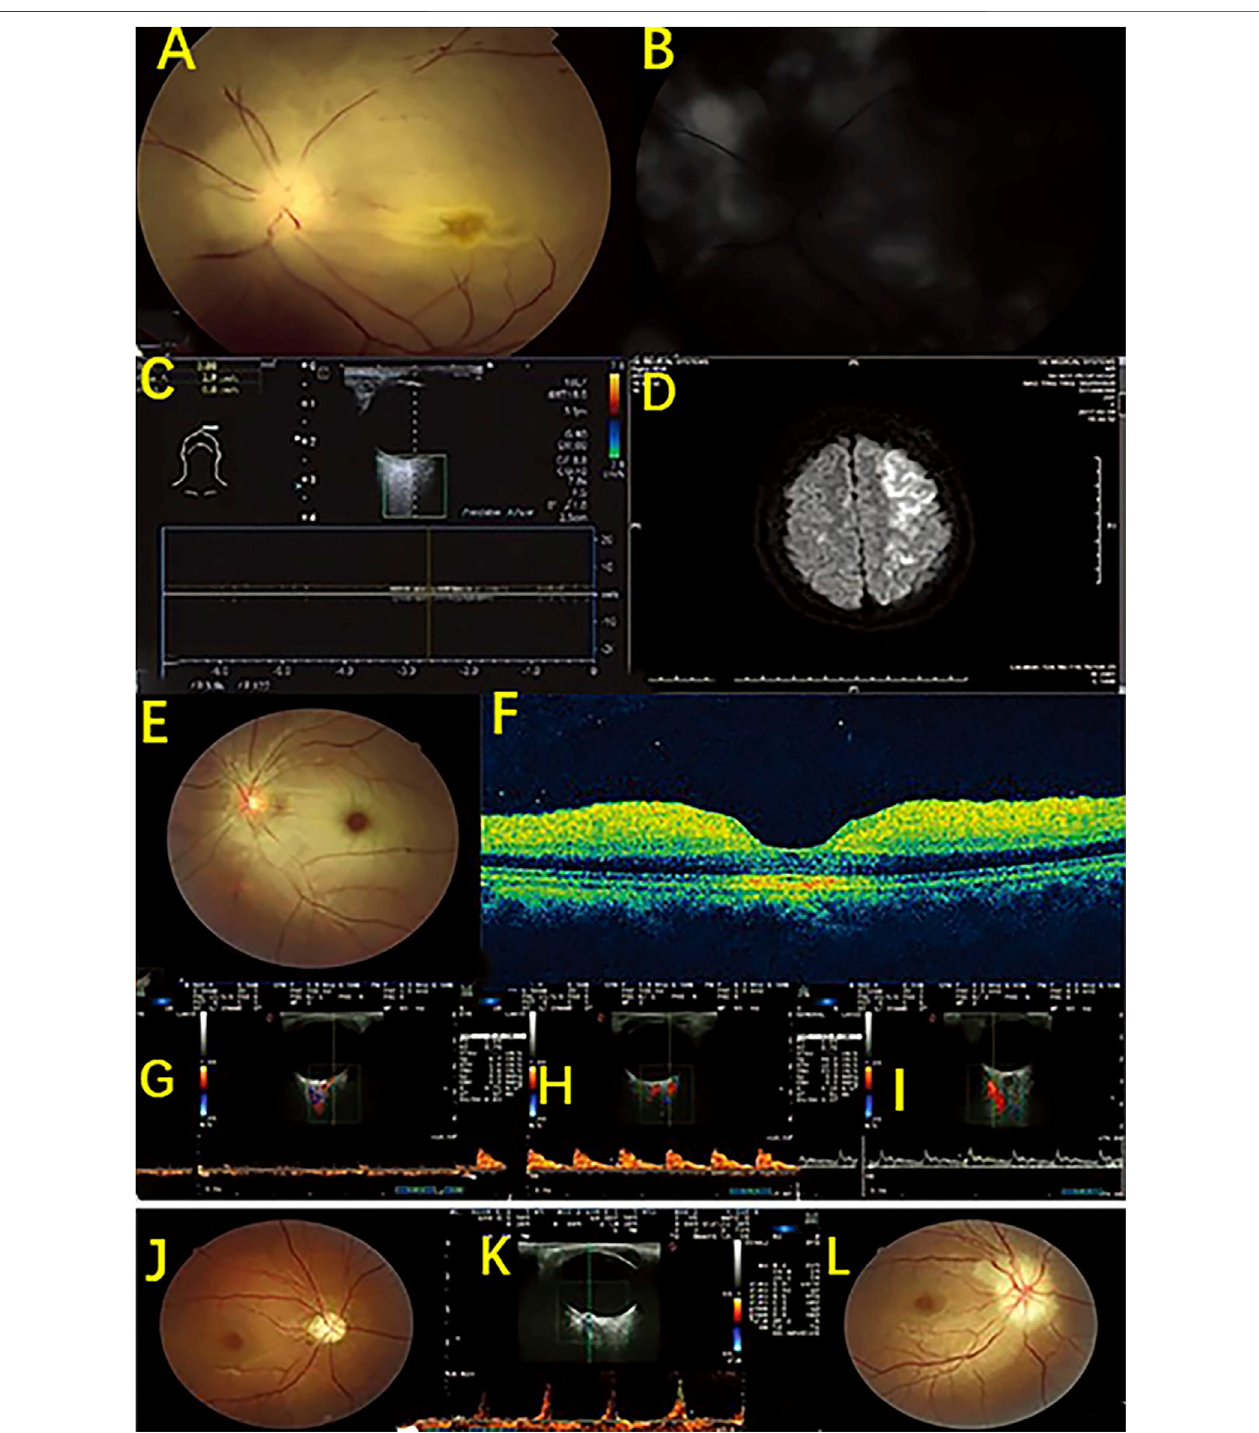
FIGURE 8 | HFUS detection of retroocular artery occlusions resulting from cosmetic facial fi ller injections. Case 1. An ophthalmic artery occlusion caused by a cosmetic autologous fat injection. (A) Fundus photograph displaying diffuse retina edema and segmented retinal arteries; (B) Fundus fl uorescein angiography showing severedamagetochoroidalandretinal fi lling; (C) CDFIdisplayingnoretrobulbarblood fl owsignal; (D) Diffusionweightedimageshowingalargeareaofacuteinfarctionin the left posterior temporal lobe and occipital lobe. Case 2. A case of central retinal artery occlusion caused by a cosmetic autologous fat injection. (E) Fundus photograph image showing retinal whitening with a cherry red spot. (F) Optical coherence tomography image indicating inner retinal edema. (G – I) CDFI shows no retrobulbarblood fl owsignalinthecentralretinalartery,aslightreductionintheposteriorciliaryarteries,andanormalblood fl owsignalintheophthalmicartery.Case3.A case of anterior ischemic optic neuropathy after a hyaluronic acid injection. A fundus showing optic disc edema at baseline (J) and pale optic disc at follow-up (L) ; (K) CDFI showing a decreased end diastolic velocity and an increased resistance index and pulsatility index of the central retinal artery and a high peak velocity of arterial